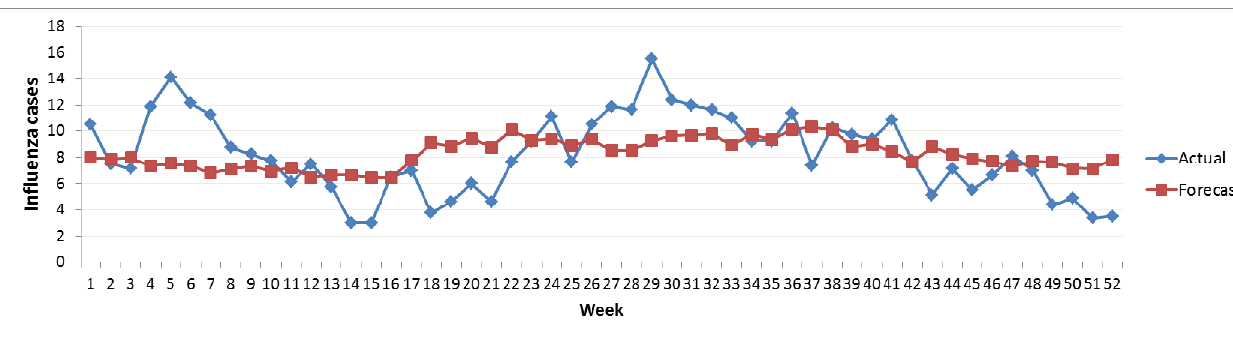
Figure 6. Relationship between actual and forecast influenza incidences